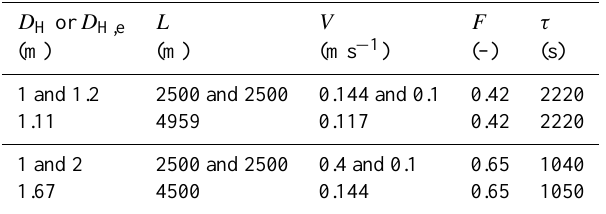
Table 2. Thermal transmission factors and retardation values of variable D H and constant D H,e